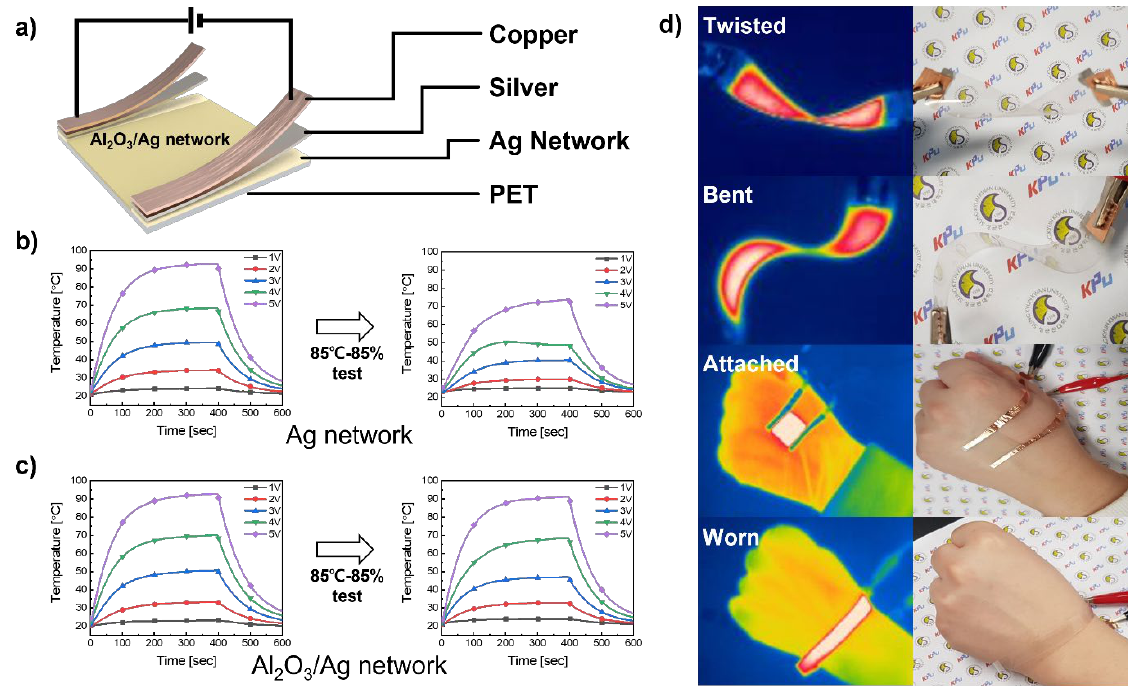
Figure 6. ( a ) Schematic of the TFH device. Temperature profiles of ( b ) bare Ag network-based TFH and ( c ) Al 2 O 3 /Ag network-based TFH before and after the 85 °C–85% RH test. ( d ) Irradiation images and photographs of the TFH devices in various deformation states, including twisted, bent, at- tached, and worn states. and worn